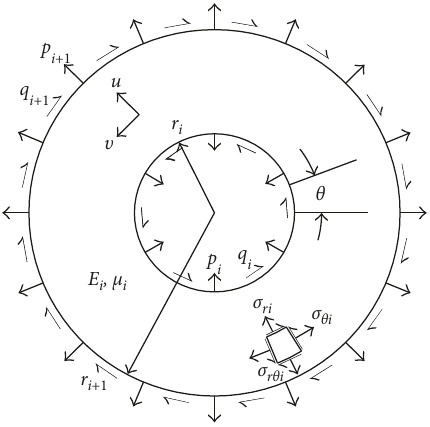
Figure 2: Mechanical model II: single-layer